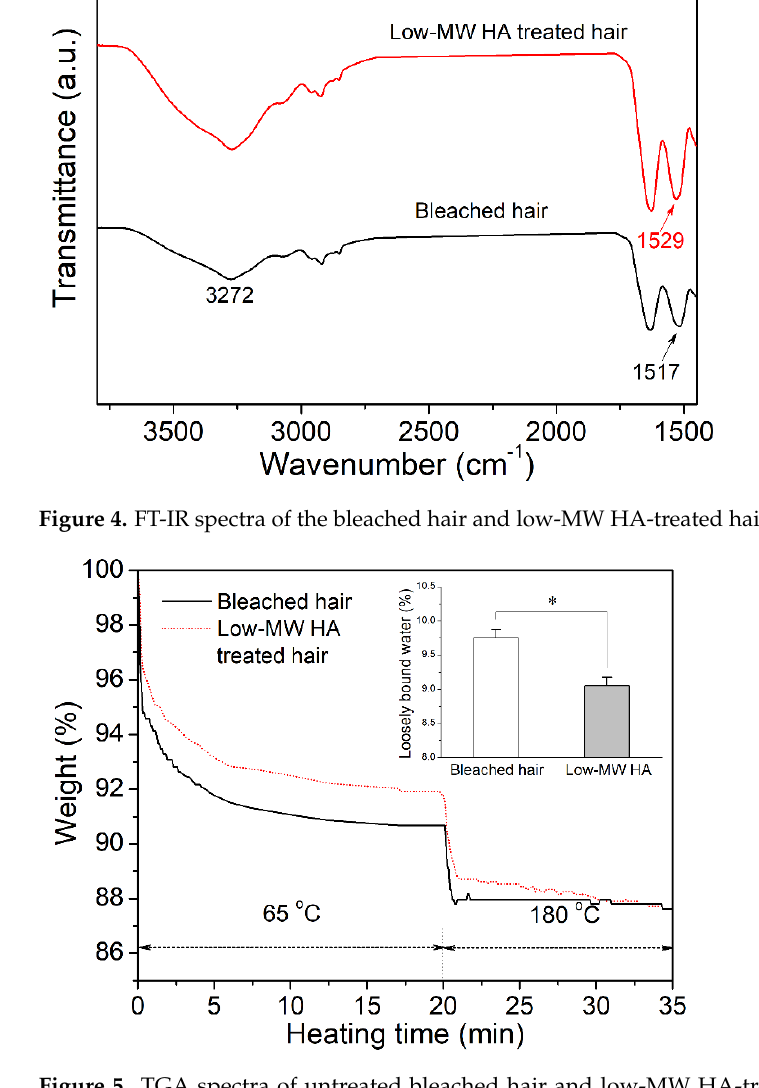
Figure 4. FT-IR spectra of the bleached hair and low-MW HA-treated hair.